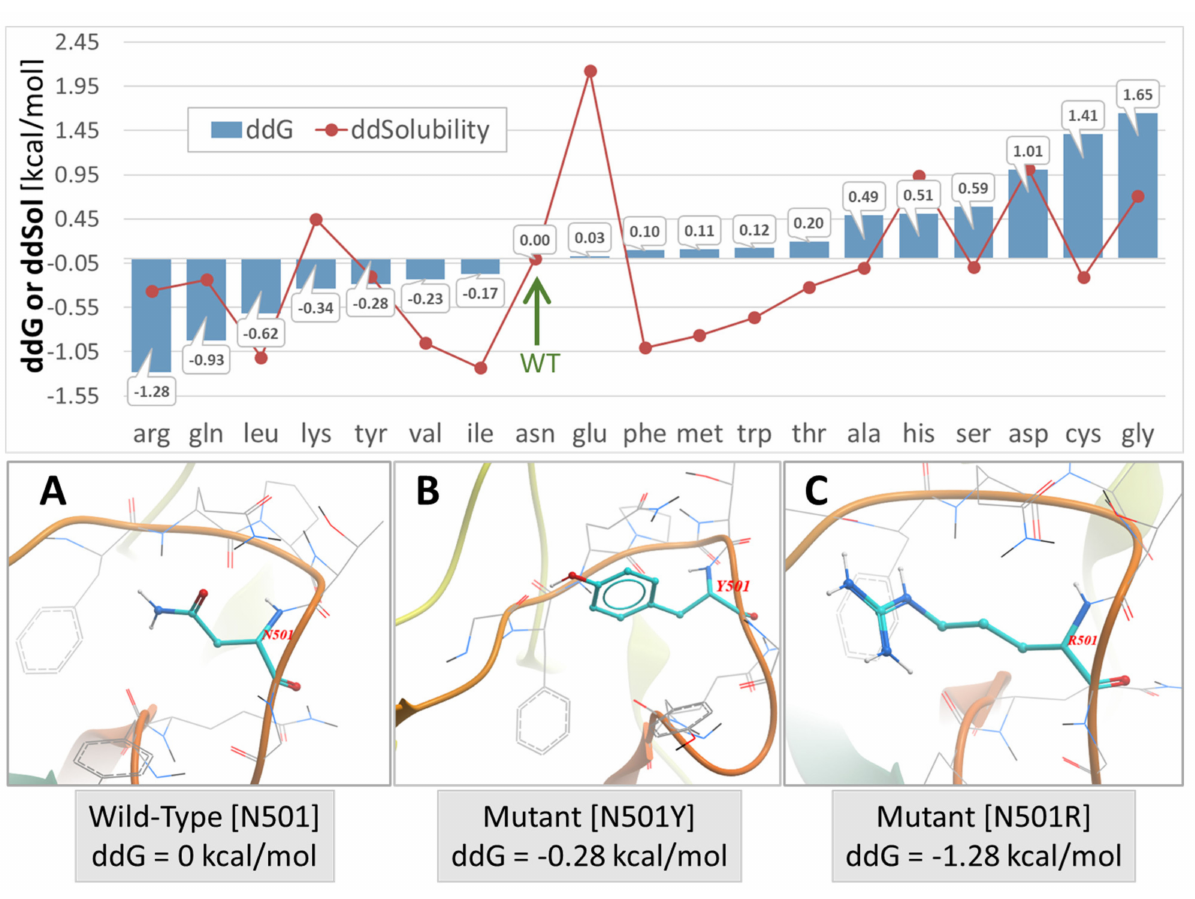
Figure 4. Upper Panel : S-protein (Swiss Model #05) stability expressed by change in ddG or free- energy of solubility (ddSol) plotted as a function of mutation type (amino acid substitution) at the N501x locus of PDB 7KGK. The calculated free-energy values for each mutation are expressed relative to the wild-type N501, which was assigned a value of zero. Lower values of ddG and ddSol correspond to increased protein stability. Thus, an Asn to Arg substitution at the N501 locus resulted the largest enhancement of protein stability ( − 1.28 kcal/mol). The green arrow indicates the wild- type N501 S-protein. Lower Panel : ( A ) Asn conformation at the wild-type N501 locus. ( B ) Mutant N501Y conformation. ( C ) Mutant N501R conformation. All conformers were modeled directly from the 6LZG x-ray structure using ICM-Chemist-Pro (Molsoft, LLC, San Diego, CA, USA). Atom Colors: cyan = carbon; blue = nitrogen; red/orange tubes = protein